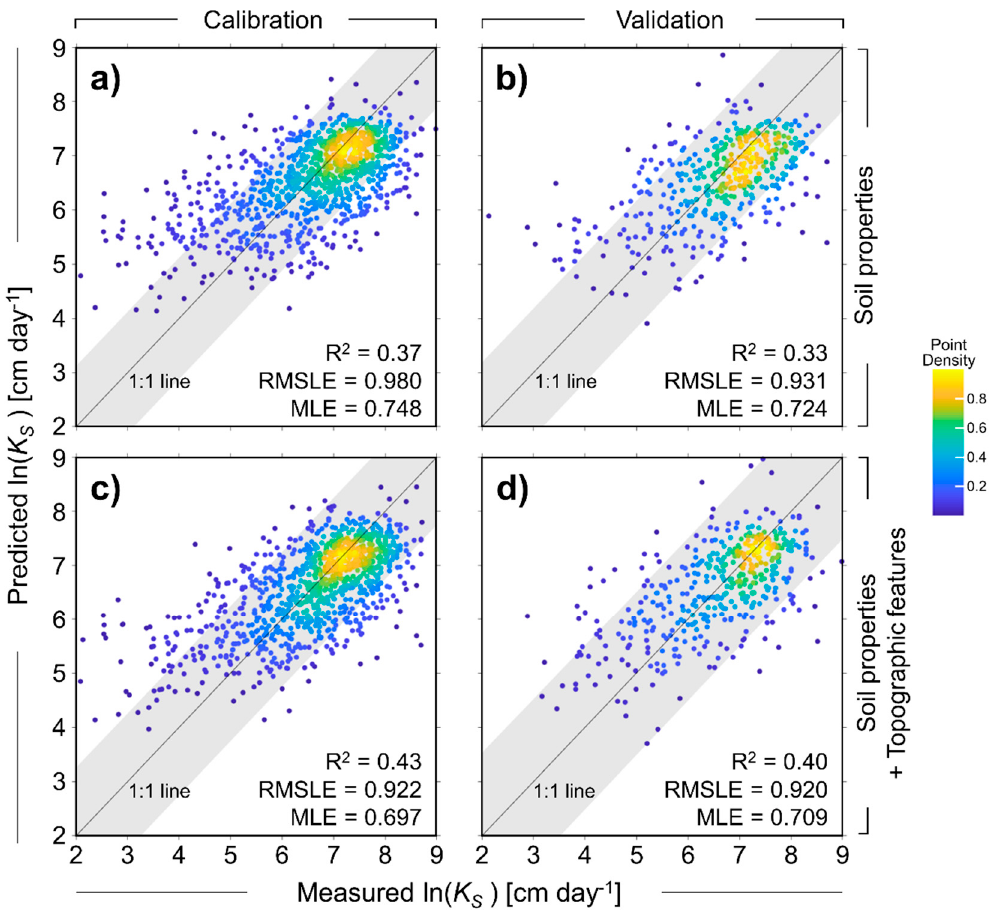
Figure 4. Relationship between the measured and predicted logarithmic K s value. Multiple linear regressions were conducted with the calibration data set, which represented 70% of the total data set, and validated by the validation data set, which consisted of the rest of the data. ( a , b ) show analysis with only soil properties, and ( c , d ) show analysis with topographic features in addition to soil properties. The grayed-out parts are the ranges of the 95% prediction interval limits of the 1:1 lines.